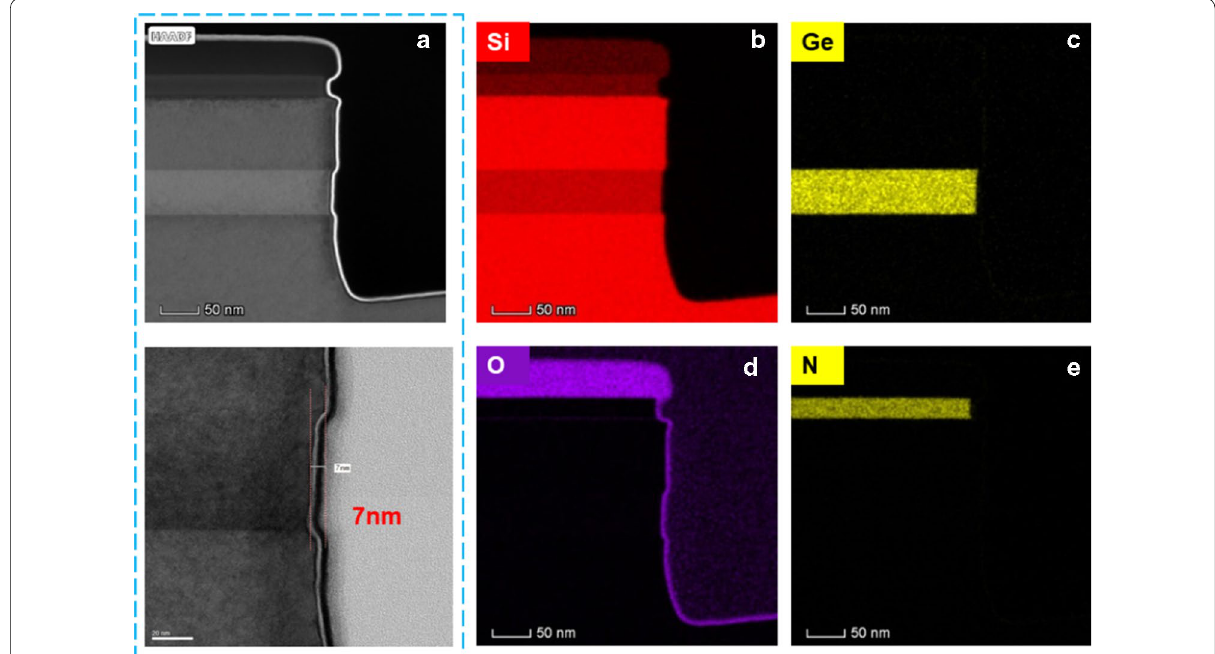
Fig. 7 a TEM images, b – e EDS mapping of P-doped Si/Si 0.86 Ge 0.14 /P-doped Si in Fig. 6a with 11.5-s dry etch. The elements in b is Si, in c is Ge, in d is O, and in e is